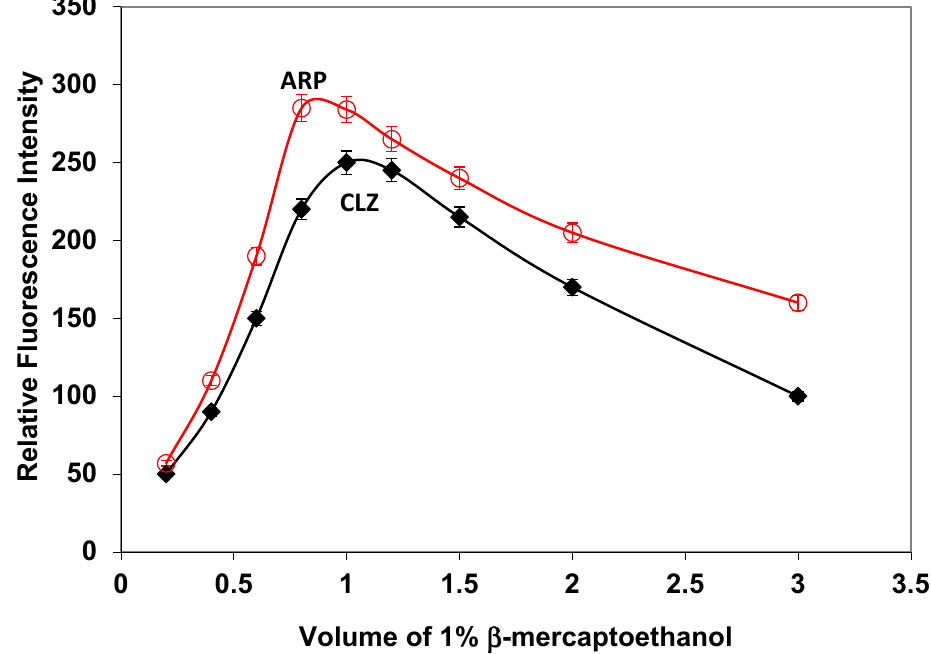
Figure 4. Effect of volume of β -mercaptoethanol (1.0% v / v ) on the fluorescence intensity of the reaction product of ARP and CLZ with o -phthalaldehyde in borate buffer.